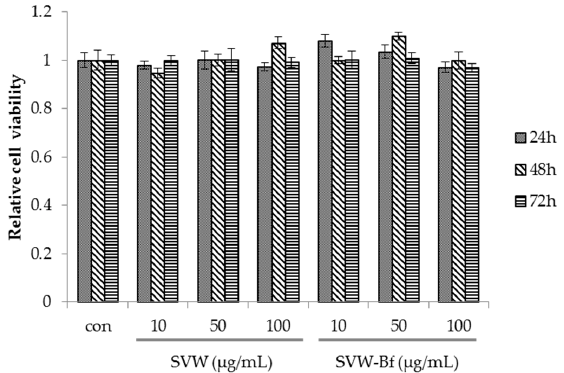
Figure 3. Effect of the SVW and the SVW-Bf on preadipocyte viability. 3T3-L1 preadipocytes were incubated with SVW and SVW-Bf at various concentrations (10, 50 and 100 μ g/mL) for 24 h, 48 h, and 72 h. SVW is S. virgaurea var. gigantea water extracts; SVW-Bf is n -butanol fraction of S. virgaurea var. gigante water extract. Three independent experiments have been carried out.